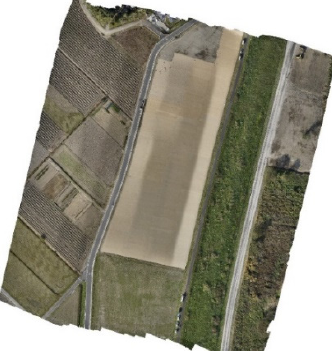
Figure 5. Orthoimage of Dataset T produced by Pix4Dmapper